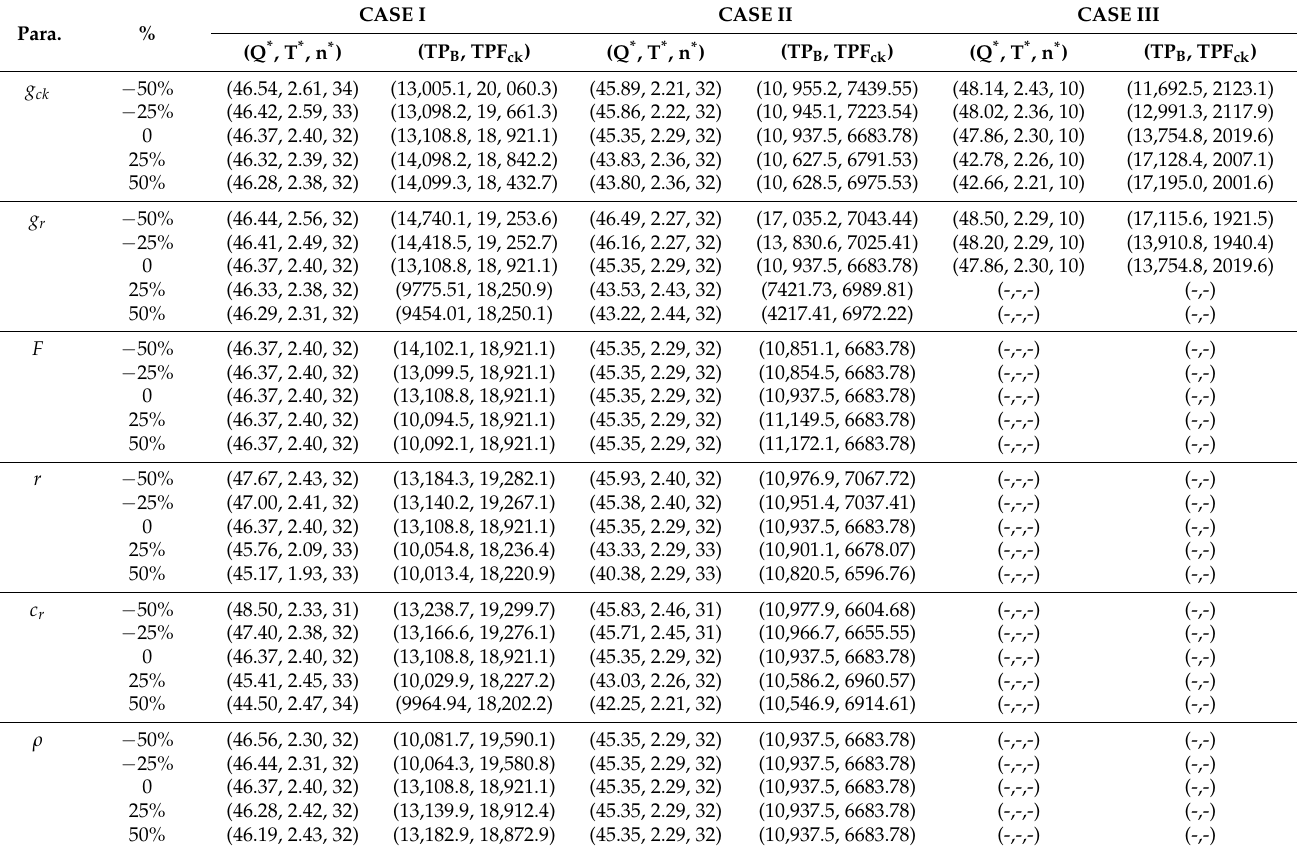
Table 4. Effect of changes in various parameters of the model.